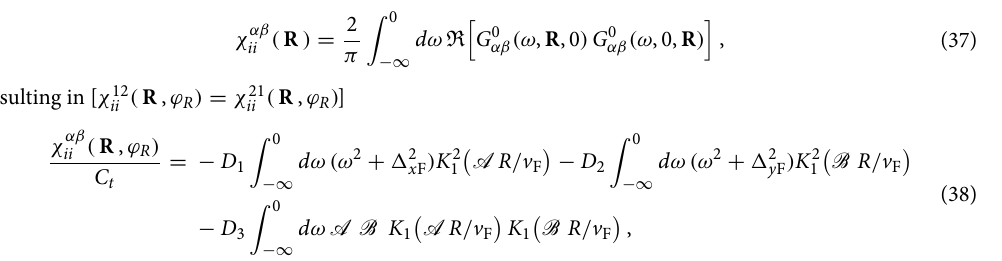
Figure 12. The behavior of the RKKY interaction Å for different ferroelectric distortion